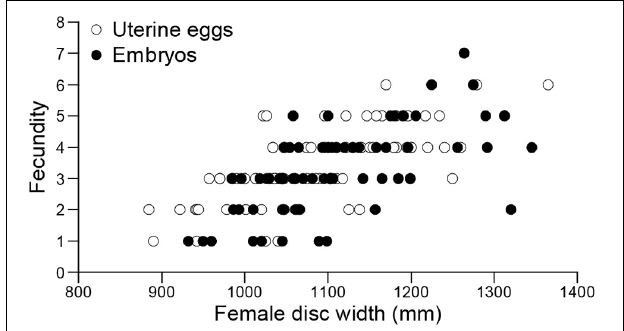
FIGURE 12 | Aetobatus narutobiei disc width and fecundity for females ( n = 158) from Ariake Bay. Fecundity ranged from 1 to 7 embryos per litter ( n = 158, mean ± SD = 3.36 ± 1.26) and was positively correlated with female disc width (linear regression; F = 105.73, d.f. = 151, P <